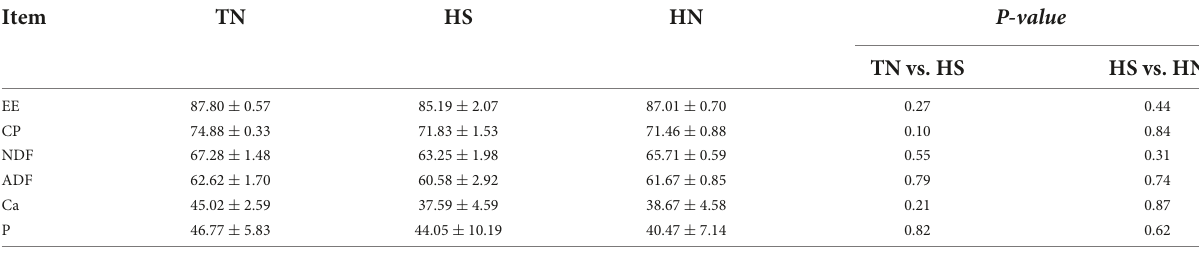
TABLE 5 Effects of dietary niacin on nutrient apparent digestibility of beef cattle under heat stress (%).